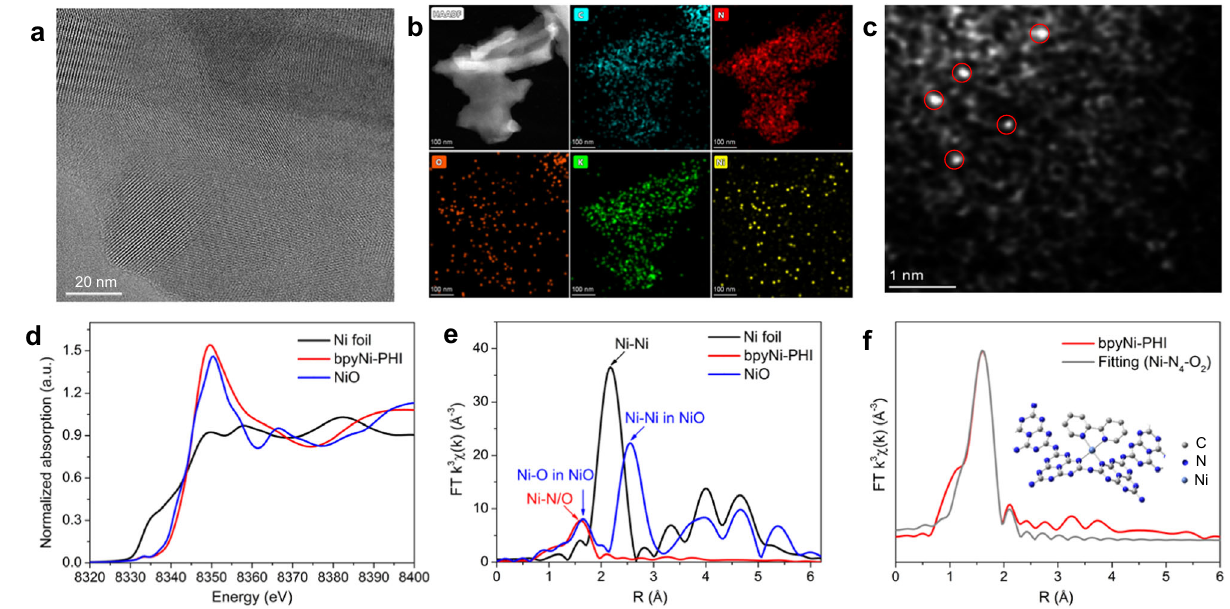
Fig. 3 | Structural characterizations ofbpyNi-PHI. a HRTEM image of bpyNi-PHI. b ElementalmappingimagesofbpyNi-PHI. c HAADF-STEMimageofbpyNi-PHI. d Ni K-edge XANES spectra. e FT-EXAFS spectra of Ni foil, bpyNi-PHI, and Ni-O.